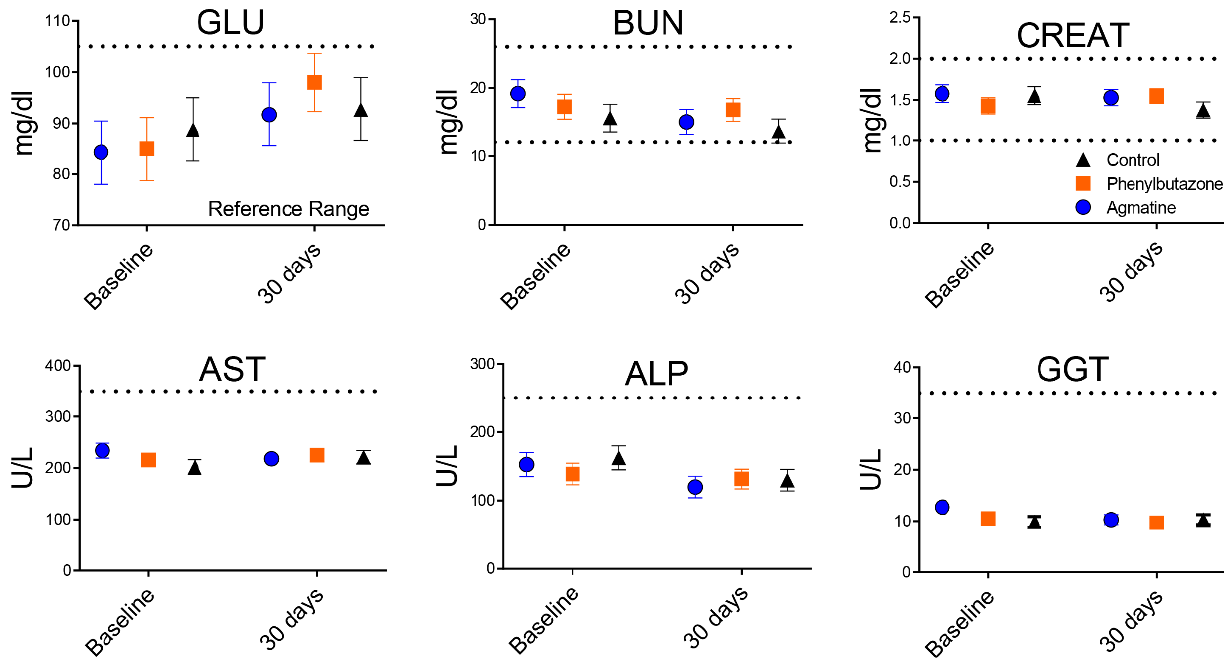
Figure 2. Plasma chemistry values before and after 30 days of oral agmatine (blue), phenylbutazone (orange), or control (black) administration. Normal reference ranges are indicated by dotted lines. GLU: glucose; BUN: blood urea nitrogen; CREAT: creatinine; AST: aspartate transaminase; ALT: alanine aminotransaminase; GGT: gamma-glutamyl transferase.